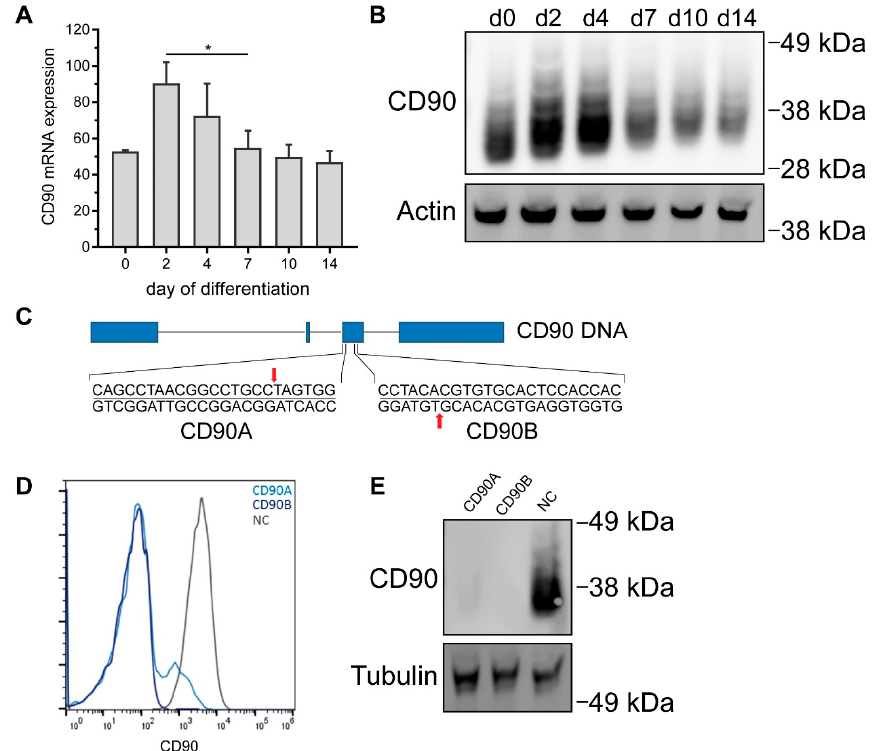
Figure 4. Generation of CD90-deficient Simpson-Golabi-Behmel syndrome (SGBS) cells using CRISPR/Cas9. Human SGBS cells were subjected to adipogenic differentiation. RNA and protein were isolated on indicated timepoints. ( A ) CD90 mRNA expression was determined by RT-qPCR. TF2B expression was used to normalize the data. Data are displayed as mean ± SEM of 3 independent experiments. * p < 0.05, one-way ANOVA with Tukey correction ( B ) CD90 protein expression was determined by Western blot. β -actin was used as a loading control. A representative experiment out of 3 independent experiments is shown. ( C ) Illustration of CD90 CRISPR/Cas9 knockout strategy. Two different sgRNAs targeting exon 3 of the CD90 gene were used. ( D,E ) SGBS cells were transfected with plasmids containing a non-targeting sgRNA (NC sgRNA, negative control) or two different sgRNAs targeting CD90 (CD90 A and CD90B). The expression of CD90 in bulk cultures after antibiotic selection was determined by ( D ) flow cytometry and ( E ) Western blot. For Western blot, tubulin was used as a loading control. A representative experiment out of 3 independent experiments is shown.